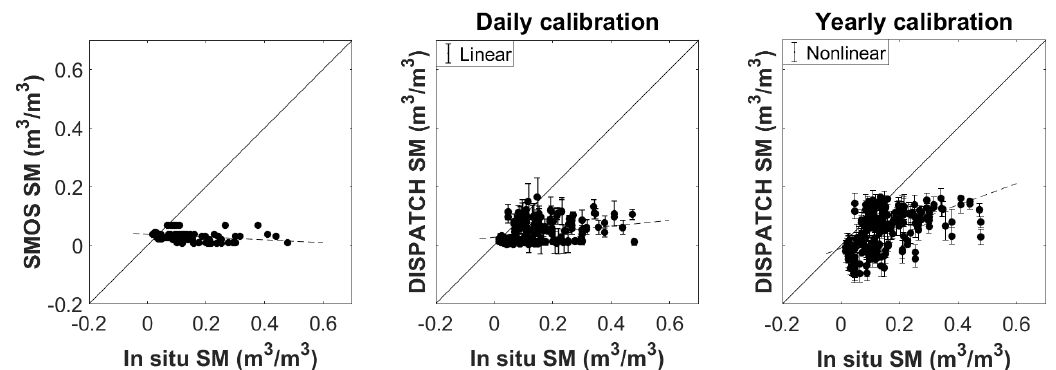
Figure 6. The SMOS and DISPATCH SM are plotted against 1 km aggregated Urgell in situ measurements (for 2011).